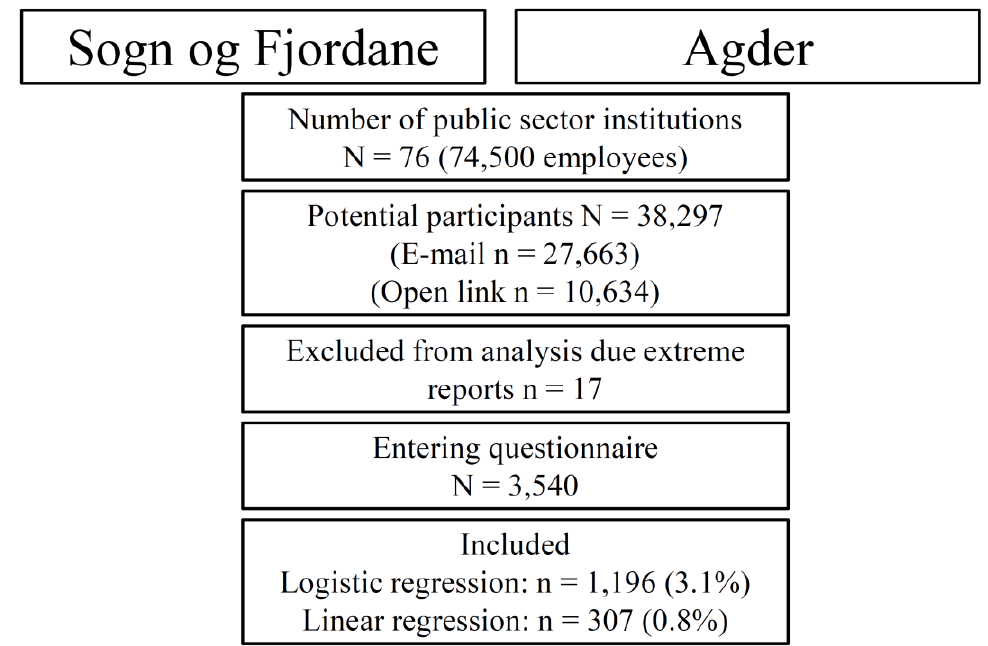
Figure 1. Flowchart and inclusion process of the Førde Active Transport study.